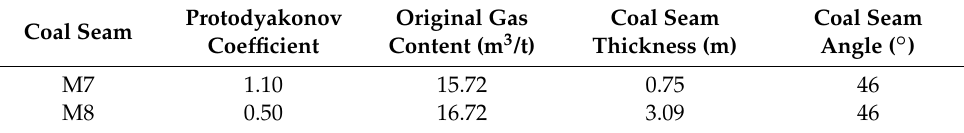
Table 1. Occurrence conditions and properties of coal seams at +300N1 rock